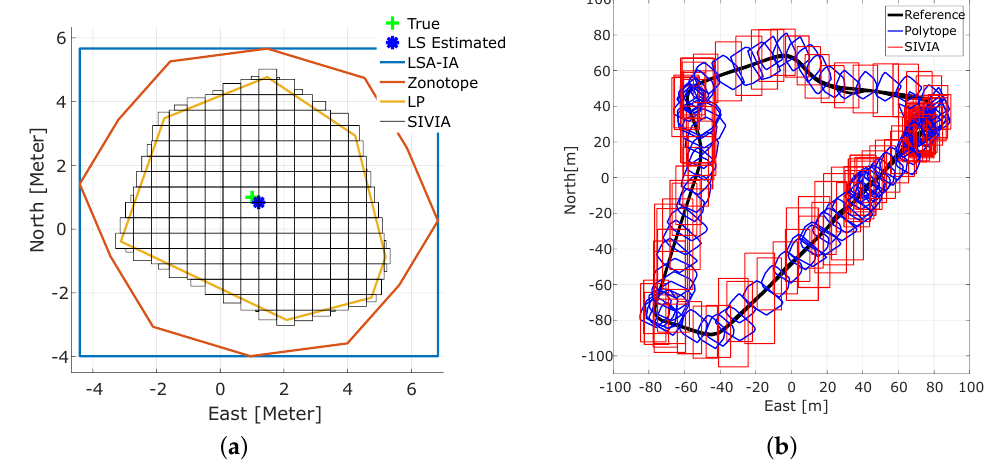
Figure 10. Comparison of different bounding methods: ( a ) 2D simulated solution sets of all methods, ( b ) Set Inversion Via Interval Analysis (SIVIA) and Linear Programming (LP) inconsistency zones from the scenario 3 test drive. LSA-IA, Least Squares Adjustment based on Interval Analysis.